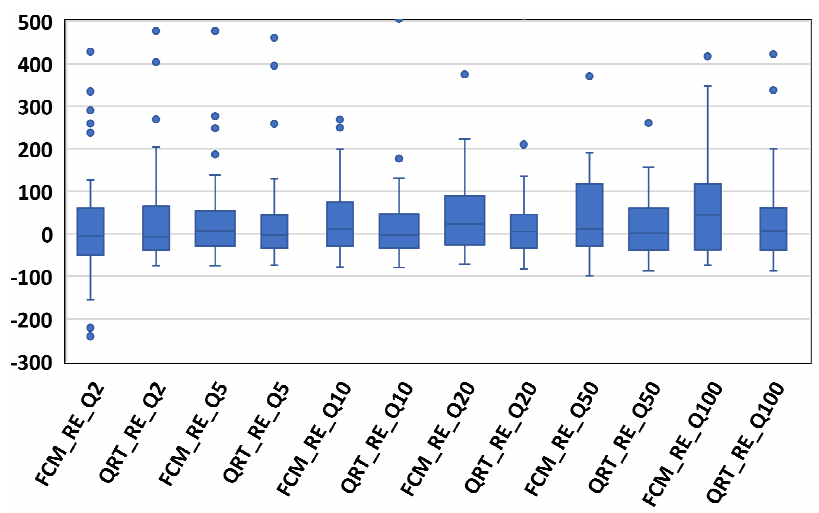
Figure 9. Comparison of boxplots of RE values for FCM and QRT.